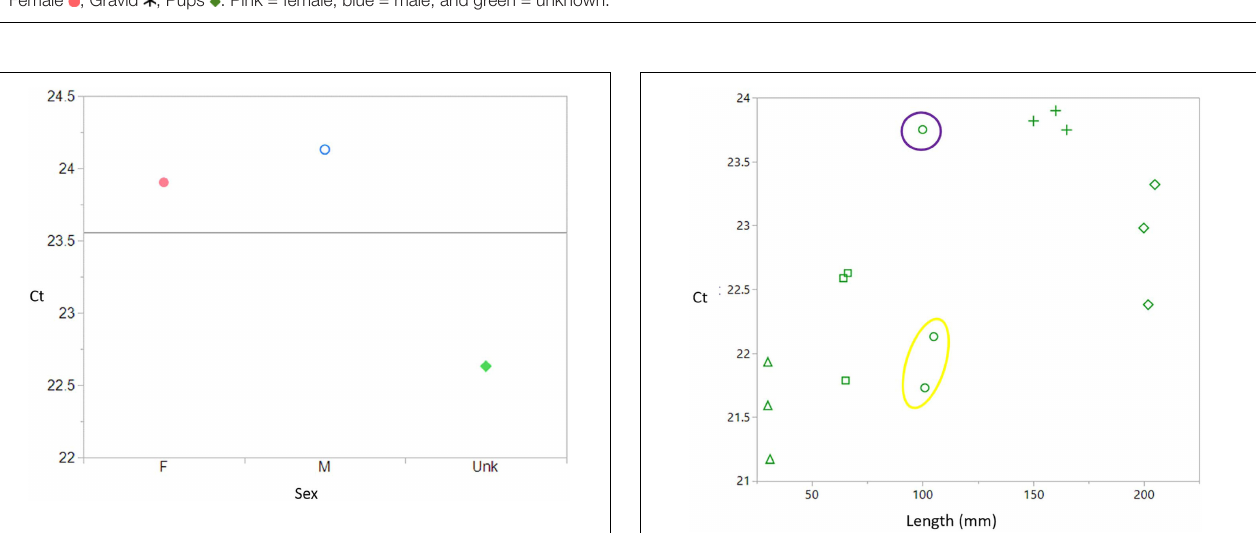
FIGURE 1 | Relationship between Ct and total length with outlier removed showing a significant relationship between the two factors ( R 2 = 0.27; p = 0.007). Male , Female , Gravid , Pups . Pink = female, blue = male, and green = unknown.